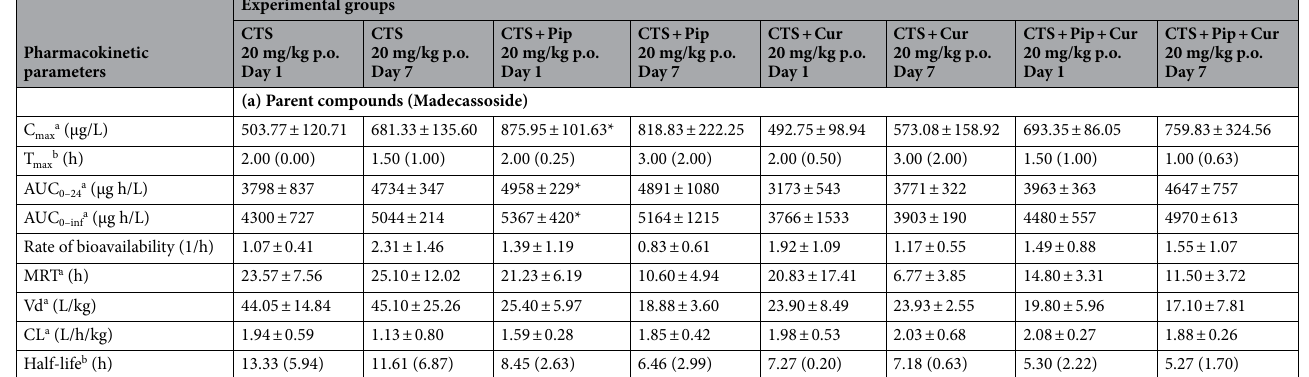
Table 2. Pharmacokinetic parameters of madecassoside after oral administration of 20 mg/kg Centell-S, 20 mg/kg Centell-S + 20 mg/kg piperine, 20 mg/kg Centell-S + 20 mg/kg curcumin, and 20 mg/kg